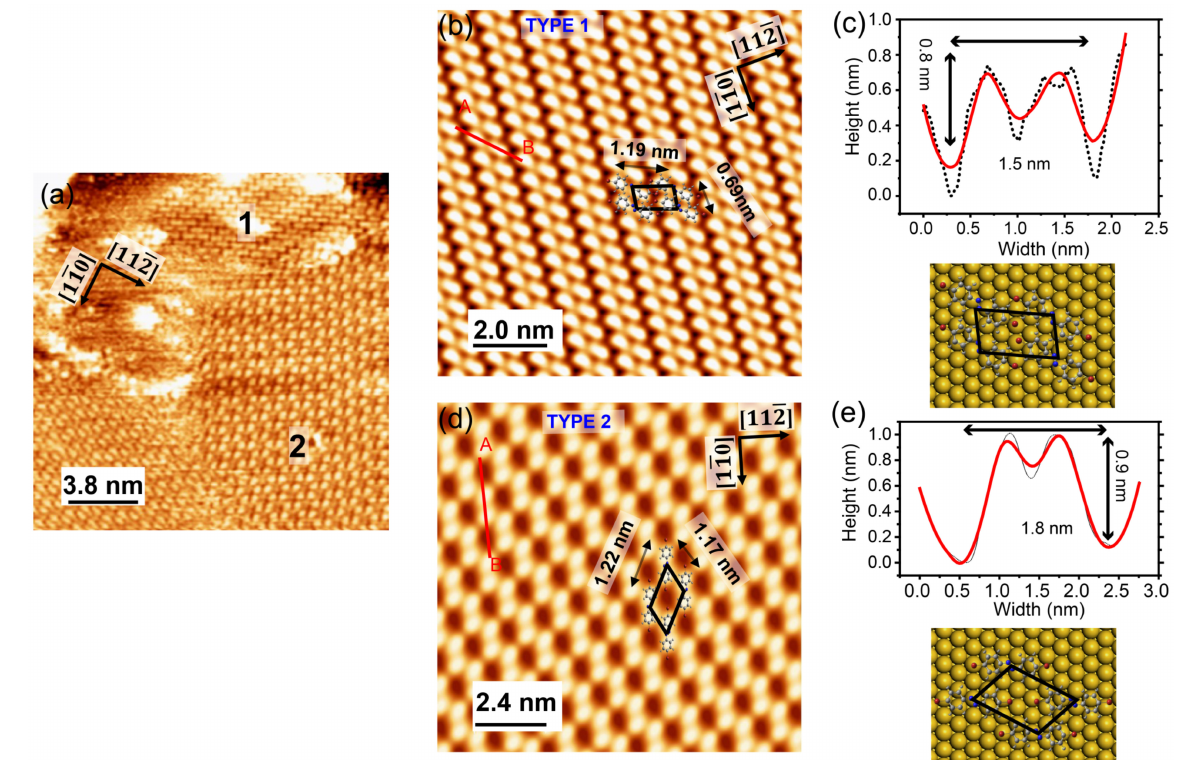
Figure 3. ( a ) STM topographic image of Br-AB molecules on Au(111) exhibits domains with different molecular orientations ( − 0.5 V, 0.7 nA, 19 × 19 nm 2 ). ( b ) Two-lobe structure of Br-AB type 1 molecules on the Au(111) substrate surface ( − 0.5 V, 600 pA, 10 × 10 nm 2 ). ( c ) Height profile of the dibromo- azobenzene molecule on Au(111) in the type 1 phase, measured along the red line (A–B in the panel) ( b ). The bottom panel shows the ball-and-stick model of the Br-AB molecule representing the arrangement, as seen in ( b ). ( d ) The STM topographic image of the type 2 configuration of the Br-AB molecules ( − 1.2 V, 0.6 nA, 12 × 8 nm 2 ). ( e ) Height profile of the dibromo-azobenzene molecule on Au(111) in the type 2 phase, measured along the red A–B line in panel ( d ). Bottom panel shows ball-and-stick model of Br-AB molecule representing the arrangement as seen in ( d